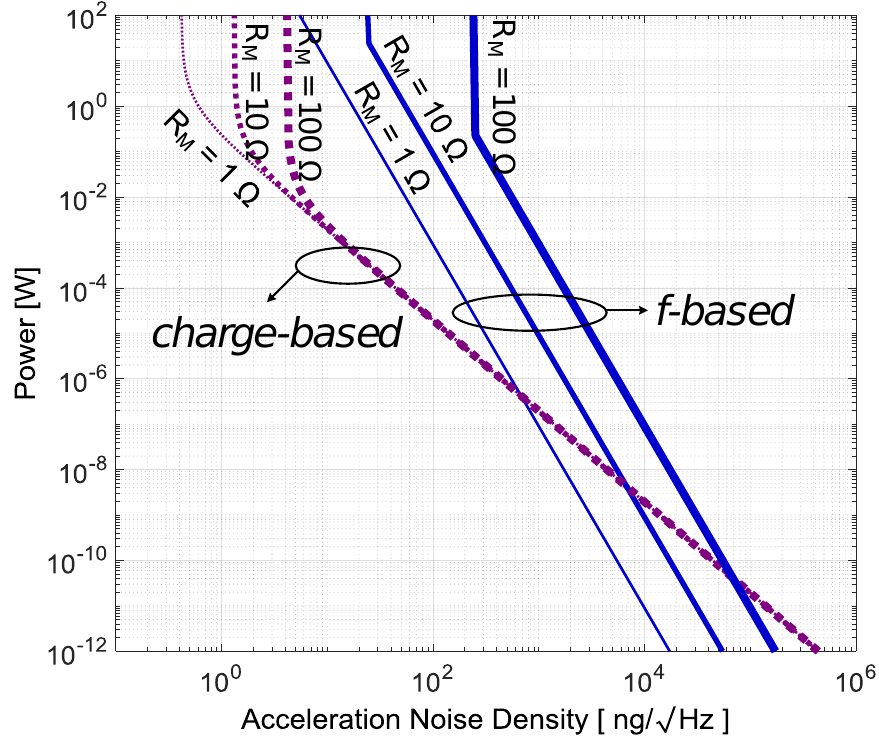
Figure 10. Power dissipation of readout circuits vs. acceleration noise density for charge-based and frequency-based ( f ) readout techniques with BW = 100 Hz, f c = 1 MHz and R M of 1 Ω , 10 Ω , 100 Ω ,